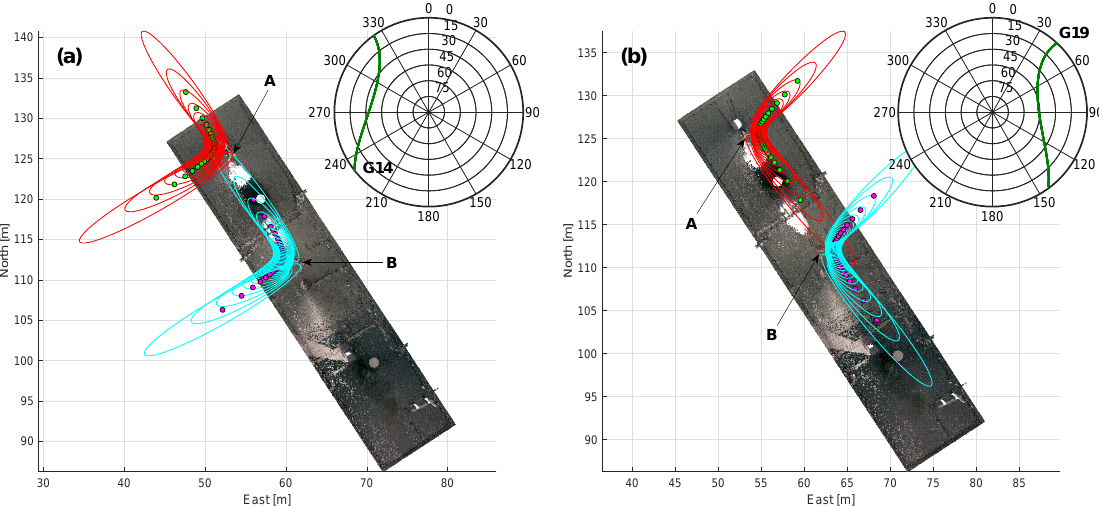
Figure 17. Fresnel zones and reflection points related to antenna A (red ellipses and green dots) and B (cyan ellipses and magenta dots) for satellites G14 ( a ) and G19 ( b ) in a topocentric coordinate system. The Fresnel zones are shown for every hundreth observation epoch. Top right in left and right figures: skyplot with satellite tracks of G14 and G19, where the PRN number is located at the end of each